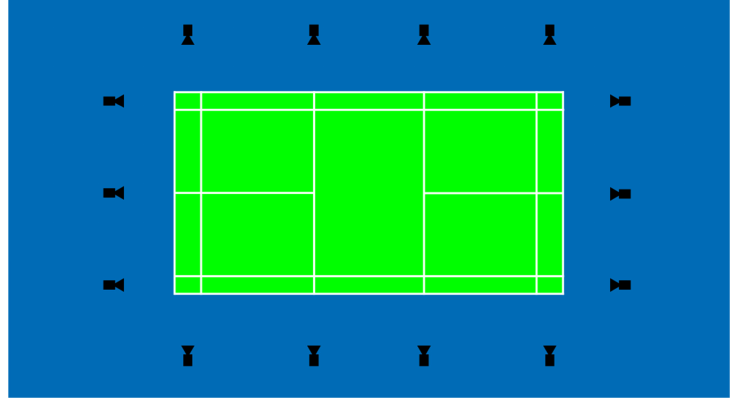
Figure 5. Cameras’ placement.